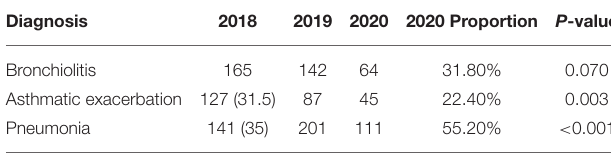
TABLE 3 | Number of hospitalizations per year for each